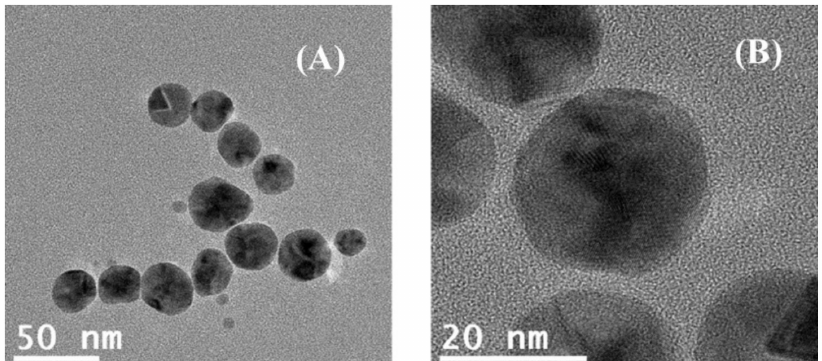
Figure 1. TEM images of AgNPs at different magnifications: ( A ): 50 nm; ( B ): 20 nm.